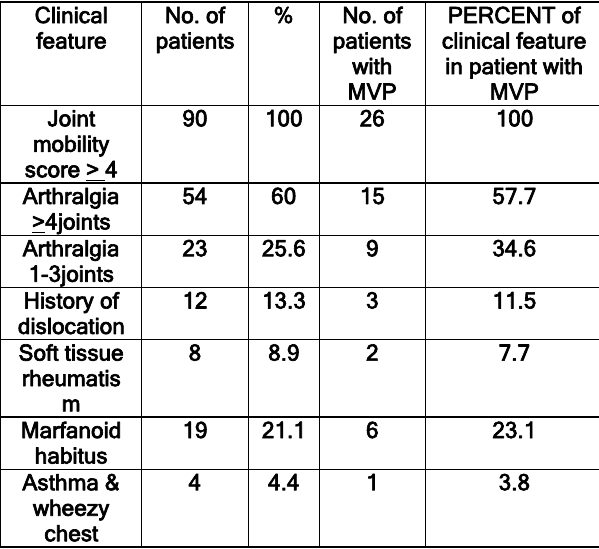
Table (2): the correlation between various clinical findings and MVP in 90 patients with BJHS.